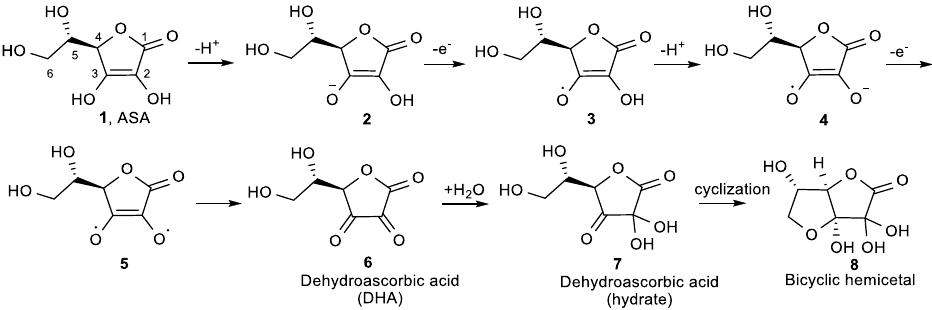
Figure 1. The mechanism for the ionization and oxidation of l -ascorbic acid (ASA) to the inactive dehydroascorbic acid 6 and bicyclic hemiacetal 8 .